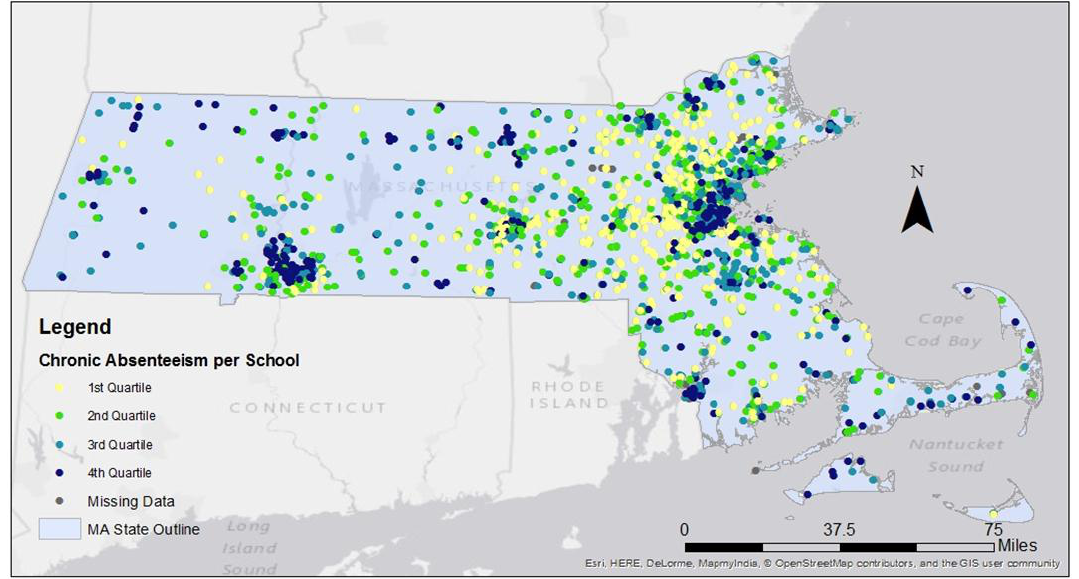
Figure 1. Quartiles of chronic absenteeism per school. Each point on the map is a school ( n = 1772). 1st quartile (0.0–5.5), 2nd quartile (5.5001–9.30), 3rd quartile (9.3001–15.30), and 4th quartile (15.30–100). MA: Massachusetts.